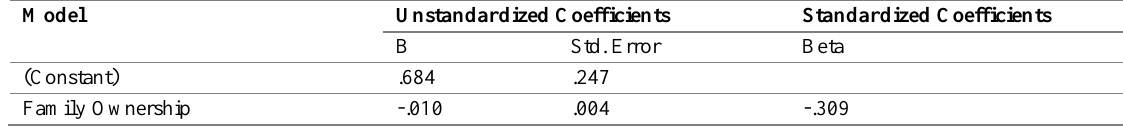
Table 3: Linear regression analysis result